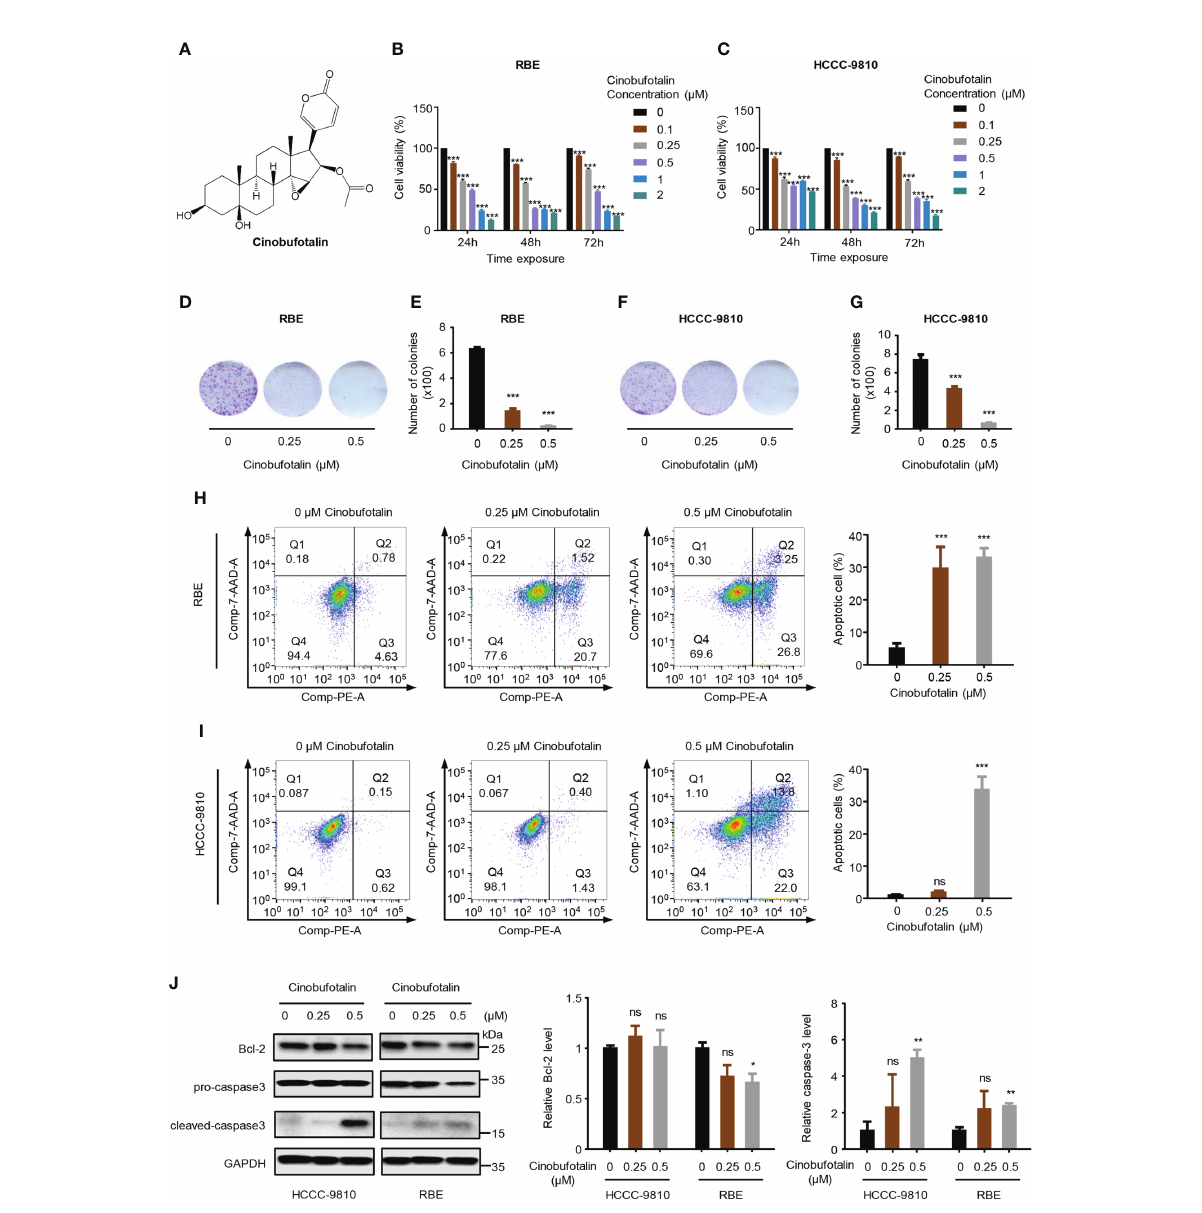
FIGURE 1 Cinobufotalin inhibits ICC cell proliferation and promotes cell apoptosis. (A) Chemical structure of cinobufotalin (CB). (B, C) RBE and HCCC- 9810 cells were treated with 0, 0.1, 0.25, 0.5, 1.0 and 2.0 m M of CB, respectively, for 24 h, 48h and 72h, and cell viability was measured by Cell counting kit-8 (CCK-8) assay. (D-G) Colony formation (D, F) and the statistics of colony counts (E, G) of REB and HCCC-9810 cells. (H-I) Flow cytometry analysis of cell apoptosis by Annexin V-PE/7-AAD staining. (J) The expression of apoptosis-related proteins in RBE and HCCC-9810 cells measured by immunoblotting and calculated by ImageJ software. * p < 0.05, ** p < 0.01, *** p < 0.001, ns denotes statistically insigni fi cant difference, Student ’ s t